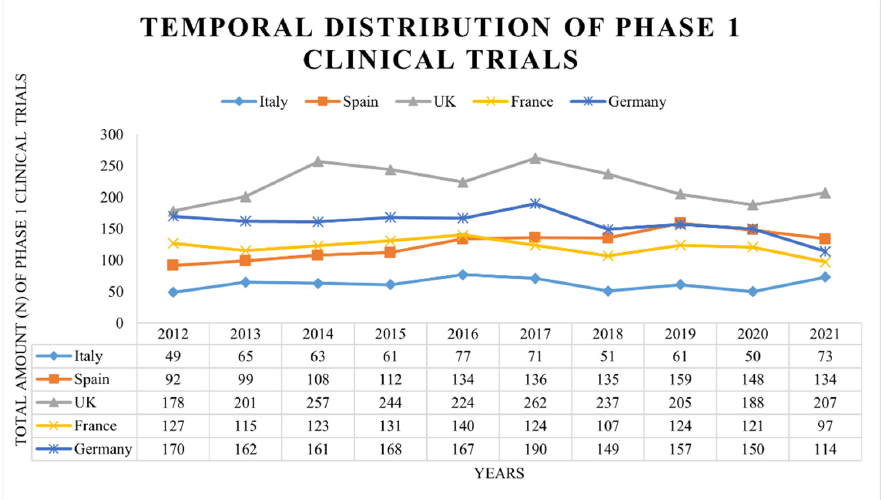
Figure 1. Temporal distribution of phase 1 clinical trials. The total number of registered phase 1 clinical trials on ClinicalTrials.gov was divided by year, from 2012 to 2021. Five European countries were selected: France, Germany, Italy, Spain and the UK.